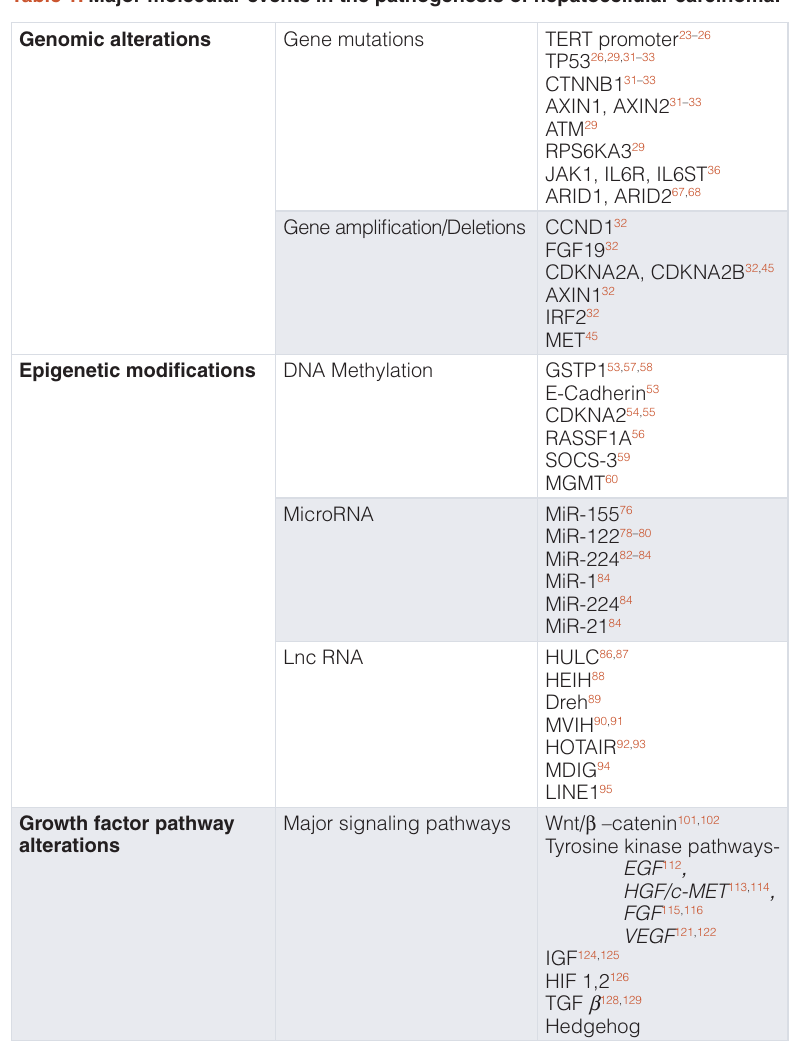
Table 1. Major molecular events in the pathogenesis of hepatocellular